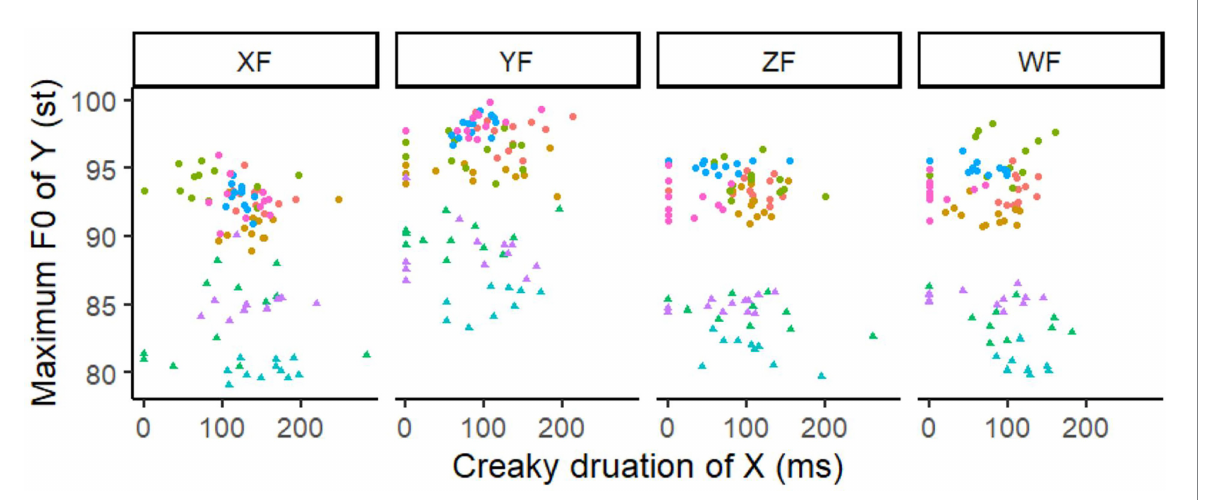
FIGURE 9 Scatter plot of the maximum F0 in syllable Y as functioned by duration of the creaky part in syllable X, with the color and shape differentiating speakers. The focus conditions are divided in each plot. The points with creaky duration of X being 0 means that this is a normal L tone.